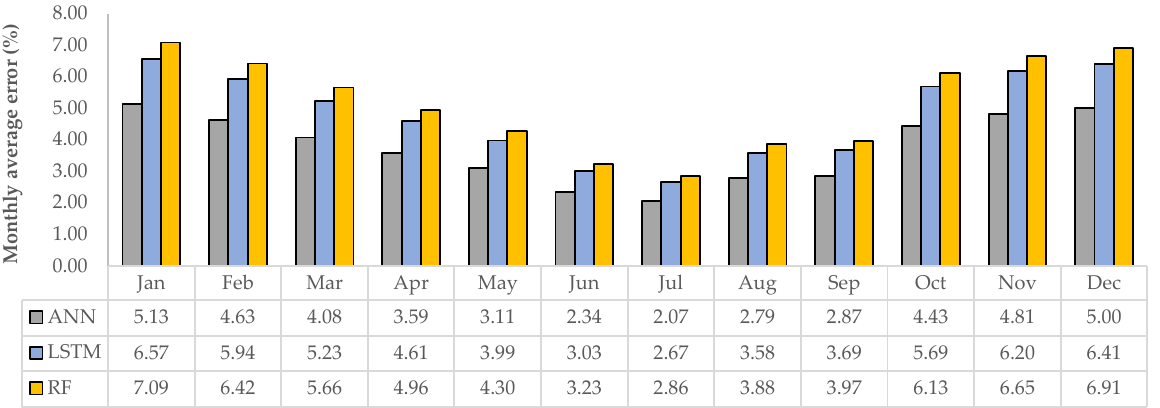
Figure 3. The annual estimation error profile of water temperature in the basin by ANN, LSTM, and RF models for the city of Tehran using the experimental data of [16].